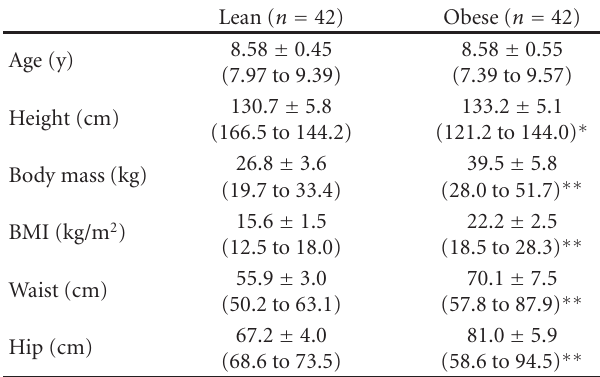
Table 1: The physical characteristics of the